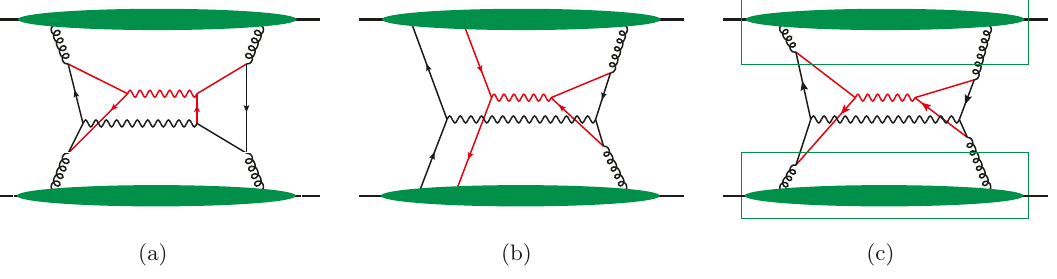
Figure 2 . (a) A higher-order graph for SPS. The loop on the l.h.s. has a momentum region associated with DPS but the loop on the r.h.s. does not. (b) Interference between DPS in the amplitude and SPS in the complex conjugate amplitude. (c) 1v1 graph in the region where the quark loop on the left is collinear whilst the one on the right is hard. This corresponds to the region of SPS/DPS interference, with the boxes indicating DPDs with perturbative splitting for the parton pair in the